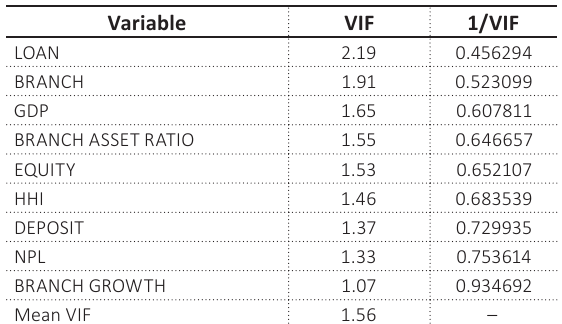
Table 4. Multicollinearity test